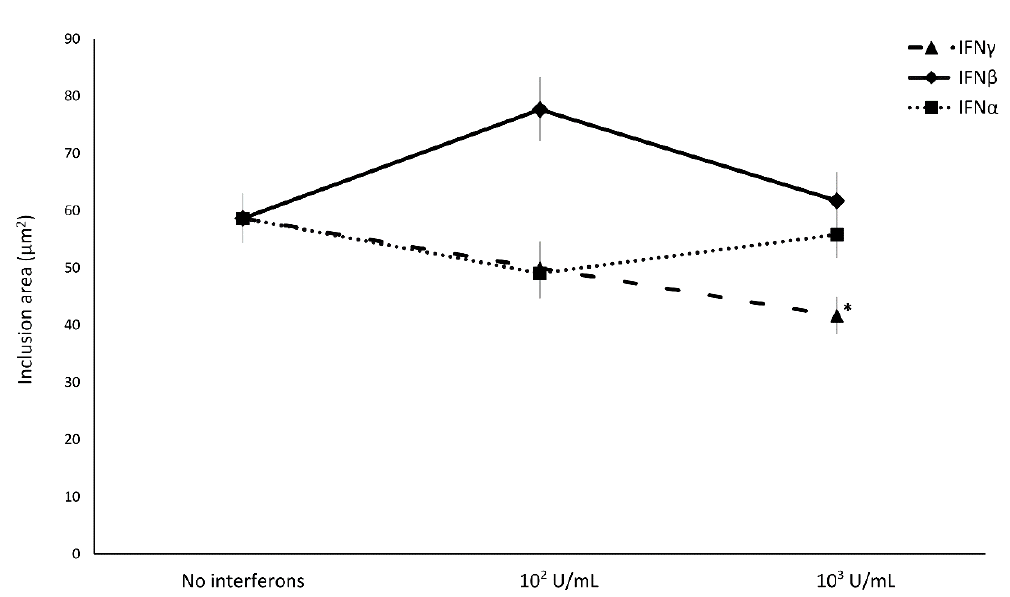
Figure 2. Anti-chlamydial activity of IFNα, IFNβ, and IFNγ following the post-infection treatment of human synovial fibroblasts. Confluent monolayers were infected with C. trachomatis and, then, treated with the IFNs (10 2 or 10 3 IU/mL) for 24 h. The total number of Inclusion Forming Units (IFUs) was determined by fluorescence microscopy, counting all green-stained inclusions at 400× magnification.